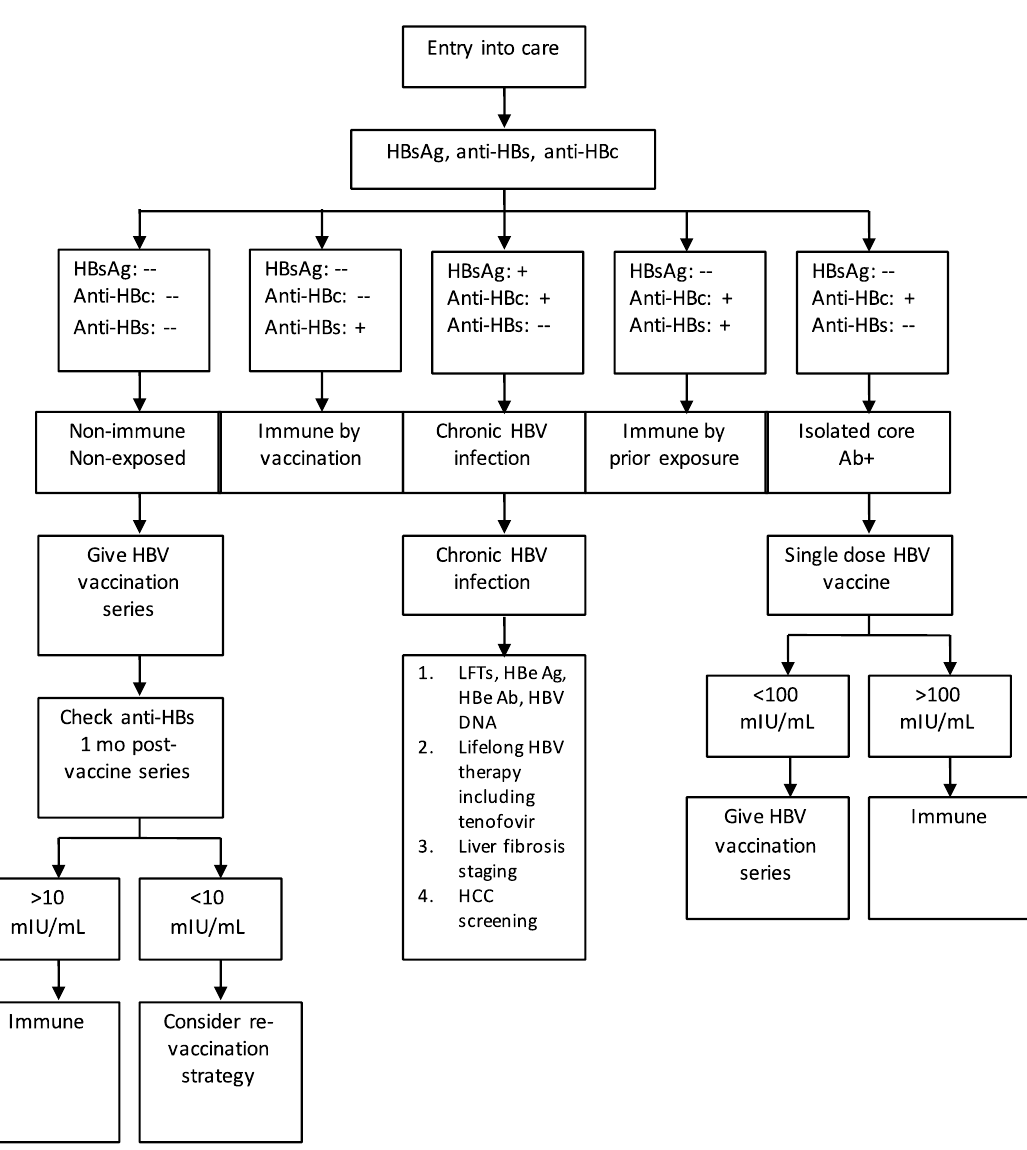
Figure 1. Algorithm of the evaluation and prevention and treatment strategies for hepatitis B virus infection in people living with HIV.